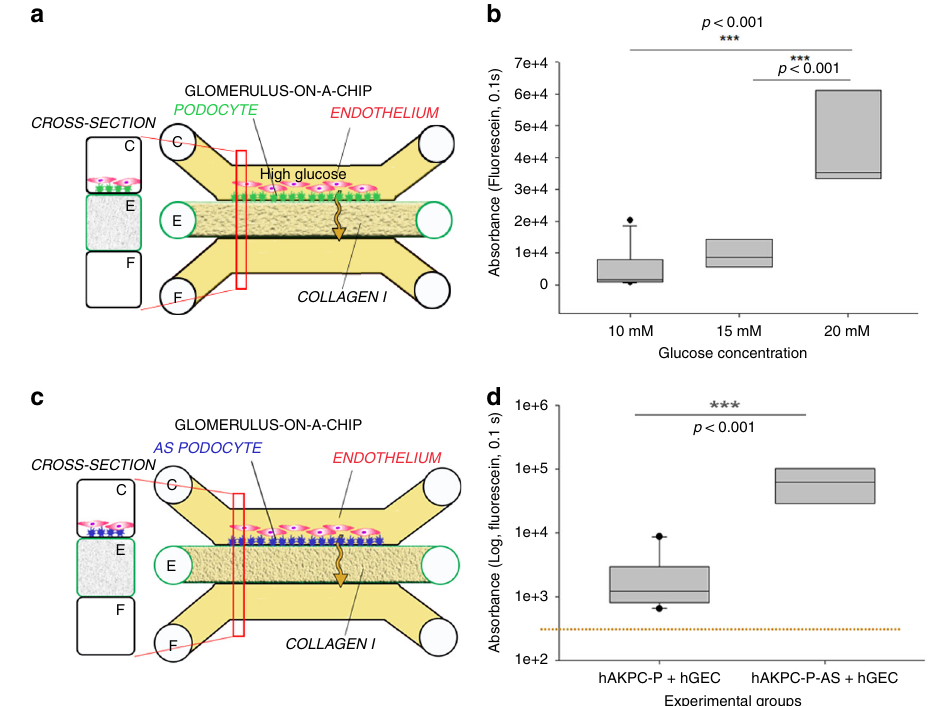
Fig. 8 Validation of the hAKPC-P GOAC system as disease-modeling platform (221). a Scheme of GOAC albumin permselectivity assay and exposure to glucose at different concentrations (10, 15, 20 mM). Following a 72 h incubation, albumin-FITC is applied to channel C (yellow) and fl ow-through presents in channel F. b Box plot graph of fl uorescein absorbance in fi ltrate collected after 60 min following 72 h incubation with 10 – 20 mM glucose. Number of replicates for chips used in b is as follows: 10 mM: #7; 15 mM: #8; 20 mM: #9. c Scheme of GOAC albumin permselectivity assay with AS-hAKPC-P + hGEC. Following formation of the AS podocyte-endothelial cell layer, albumin-FITC is applied to channel C (yellow) and fl ow-through presents in channel F. d Box plot graph of fl uorescein absorbance in fi ltrate after 60 min. Quanti fi cation of proteinuria (albumin-FITC) was performed by measuring absorbance ( fl uorescein, 0.1 s) of fl ow-through for AS-hAKPC-P + hGEC at 60 min Number of replicates for chips used in d is as follows: hAKPC-P = hGEC: #12: AS- hAKPC-P + hGEC: #7. Signi fi cant differences were determined by a one-way ANOVA and Holm – Sidak post hoc test. Box plots show the median, the 25th and 75th percentiles, whiskers (median ± 1.5 times interquartile range), and outliers (solid